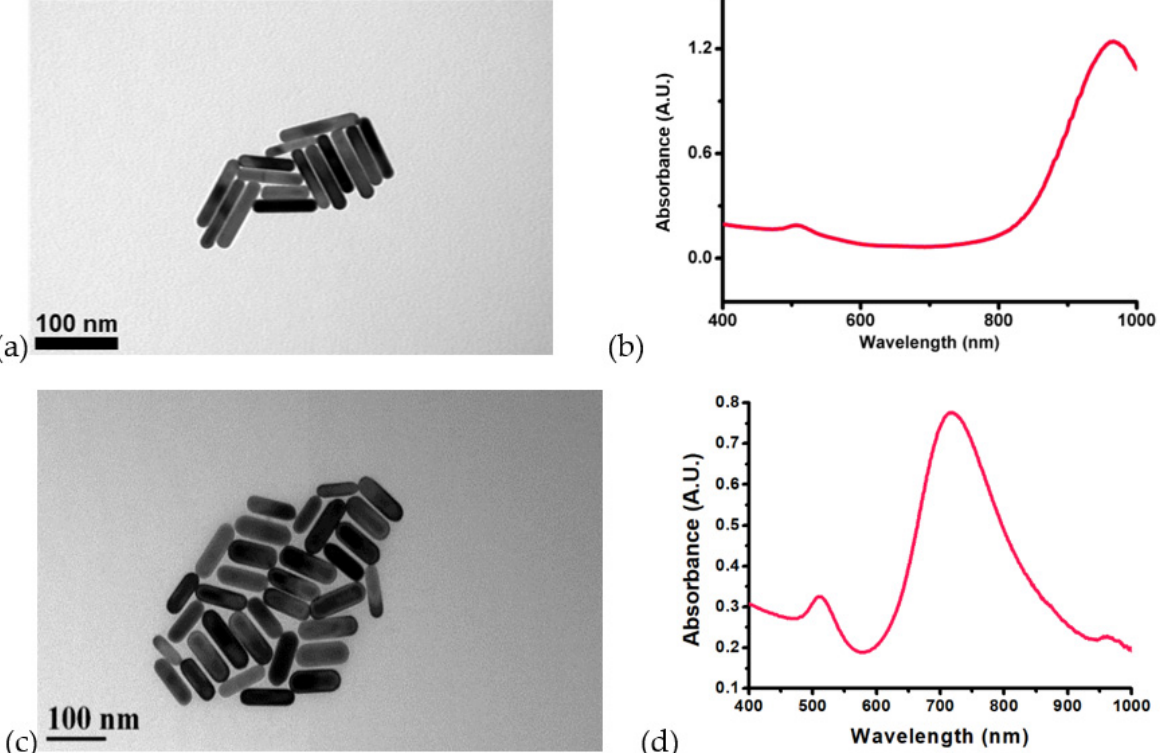
Figure 3. ( a , c ) TEM images of two kinds of GNRs with different ARs; their longitudinal SPRs are at 966 nm and 718 nm, respectively. ( b , d ) Absorbance spectra of the two kinds of